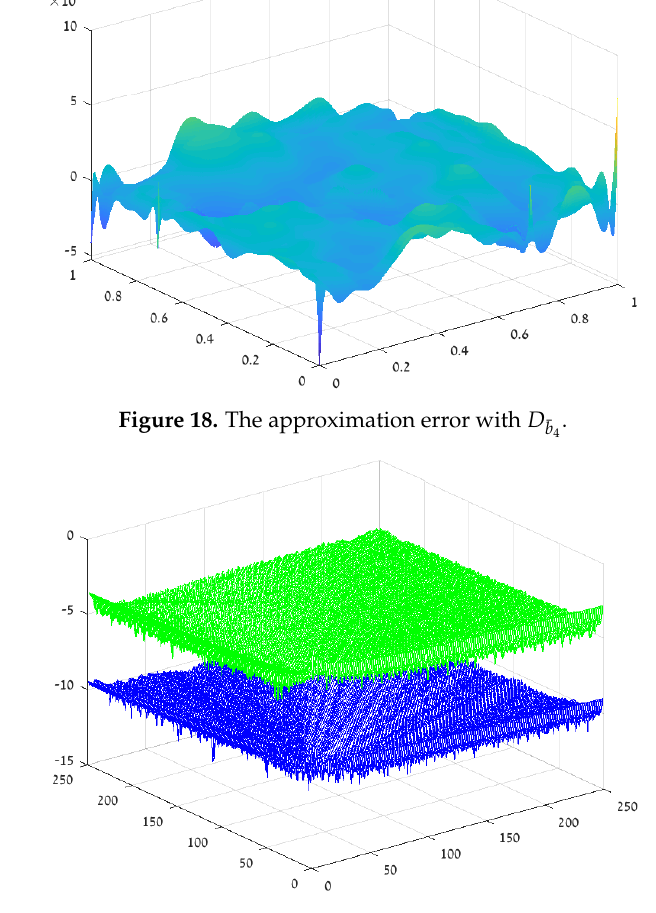
Figure 19. The magnitude reduction of the Fourier coefficients with D ¯